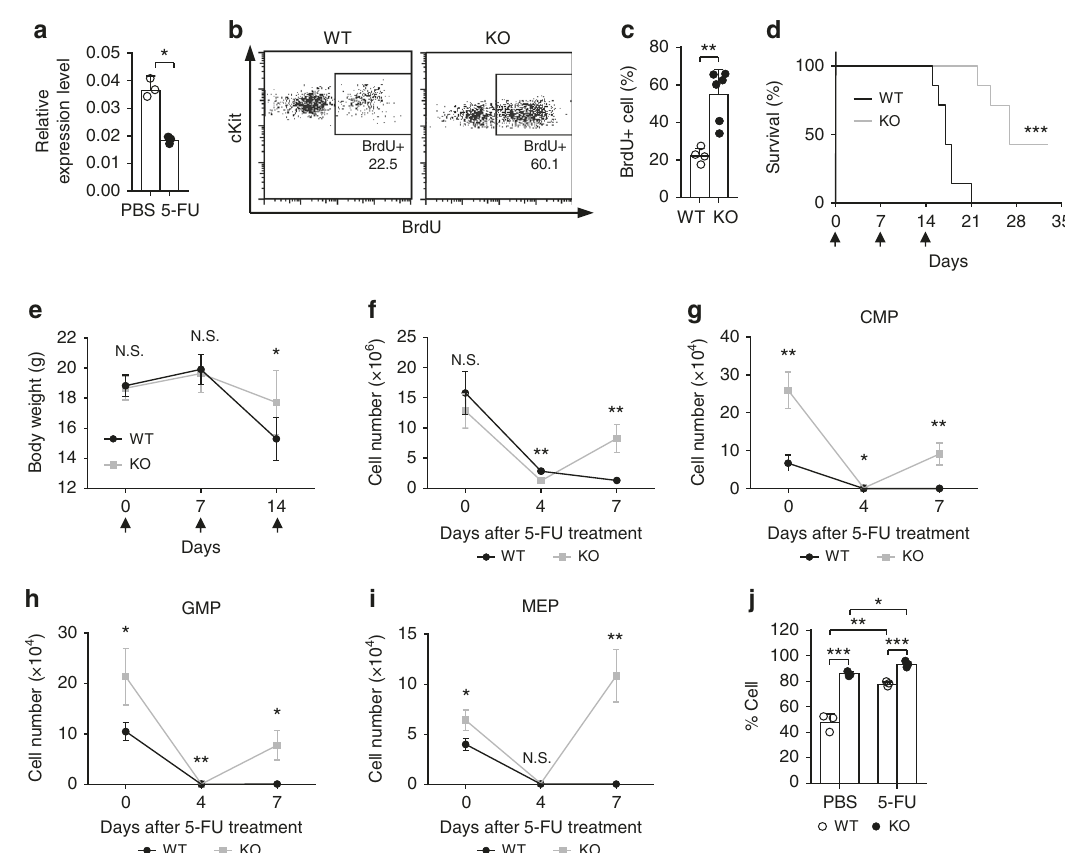
Fig. 6 Shorter recovery period and better survival of Med23 KO mice under myeloablative stress. a Med23 expression in HSC (CD150 + CD34 − CD48 − Lin − Sca1 + ) isolated from WT mice at 5 days post PBS or 5-FU injection ( n = 3). b , c Representative dot plots ( b ) and percentages ( c ) of BrdU incorporated HSCs in WT and KO mice (WT, n = 3; KO, n = 4). d Kaplan – Meier survival curve of WT and KO mice at different time points after serial 5-FU injection. Arrow shows the time points for 5-FU injection ( n = 7). e Body weights of WT and KO mice at different time points after serial 5-FU injection. Arrow shows the time points for 5-FU injection ( n = 7). f Total bone marrow cells in WT and KO mice after single 5-FU injection ( n = 3). g – i Absolute cell number of CMPs ( g ), GMPs ( h ), and MEPs ( i ) in WT and KO mice at different time points after single 5-FU injection ( n = 3). j Percent of CD41 + cells in HSCs (CD34 − CD150 + CD48 − Lin − Sca1 + ) from WT and KO mice at 7 days after single 5-FU or PBS injection ( n = 3). The data are means±S.D., for all panels: * p <0.05, ** p <0.01, *** p <0.001 by Student ’ s t -test, N.S. no signi fi cance